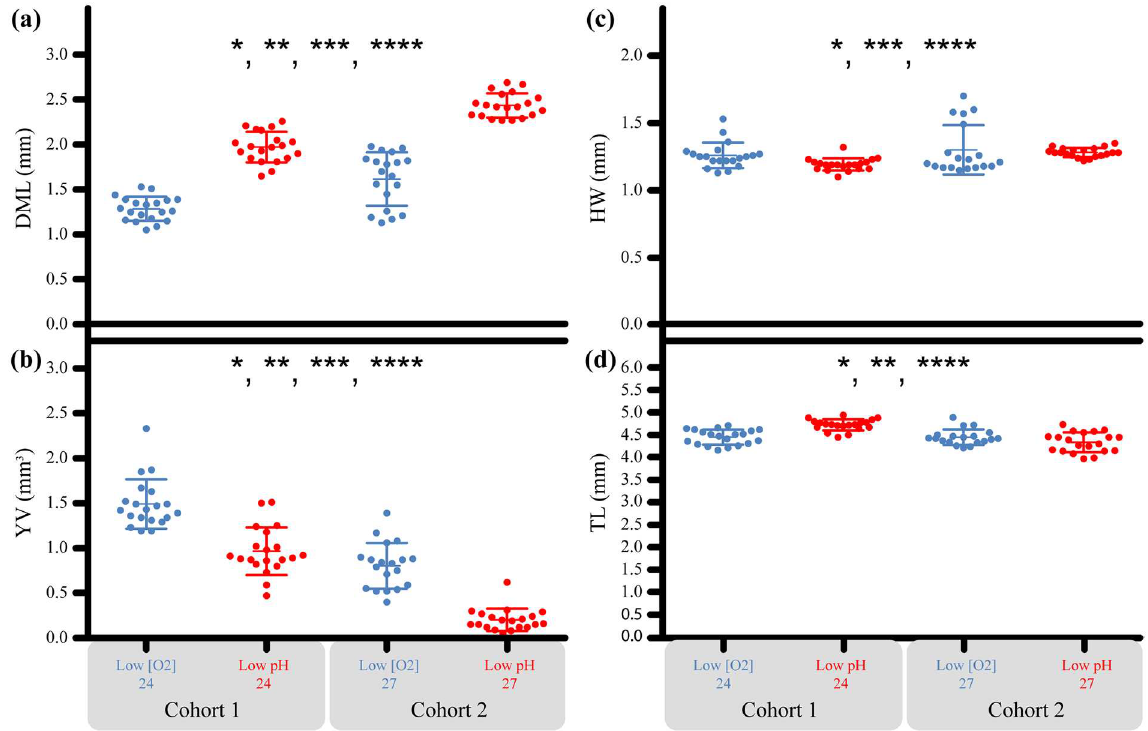
Fig 4. The embryonic response across treatmentsand exposure duration for Experiment 2. Each point representsthe averageembryo value per capsule(N = 10 embryos per capsule). X-axis: Numbers indicateexposureduration(days) and treatment is indicatedas either low pH or low [O 2 ]. (a) Y-axis = Dorsal mantle length (mm). (b) Y-Axis = Yolk volume (mm 3 ). (c) Y-axis = Head width (mm). (d) Y-axis = Total length (mm). * = treatment effect ( p < 0 . 005 ). ** = exposure durationeffect ( p < 0 . 0001 ), *** = tank effect ( p < 0 . 005 ), **** = capsuleeffect ( p < 0 . 0001) .Bars = ± 1 standard